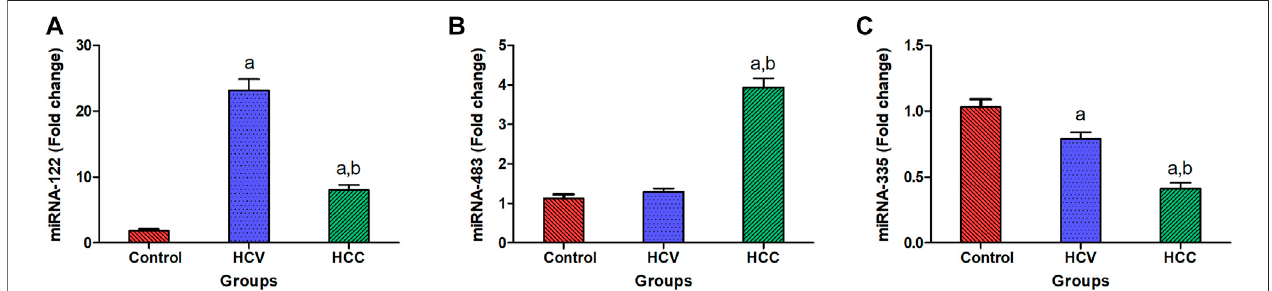
FIGURE 1 | Expression levels of miRNA-122, miRNA-483, and miRNA-335 in serum. (A) Serum expression of miRNA-122 in patients with HCC (n = 90) and HCV ( n =90)ascomparedtohealthypeople( n =60). (B) Relativetohealthypeople( n =60),thefoldchangeinserumexpressionmiRNA-483inpatientswithHCC( n =90)and HCV ( n = 90). (C) Fold change in the serum expression miRNA-335 level in HCC ( n = 90) and HCV ( n = 90) patients compared to healthy persons ( n = 60). Values are expressed as mean ± SEM (95% CI). (A) Signi fi cant difference from the control group at p < 0.05. (B) Signi fi cant difference from the HCV group at p <